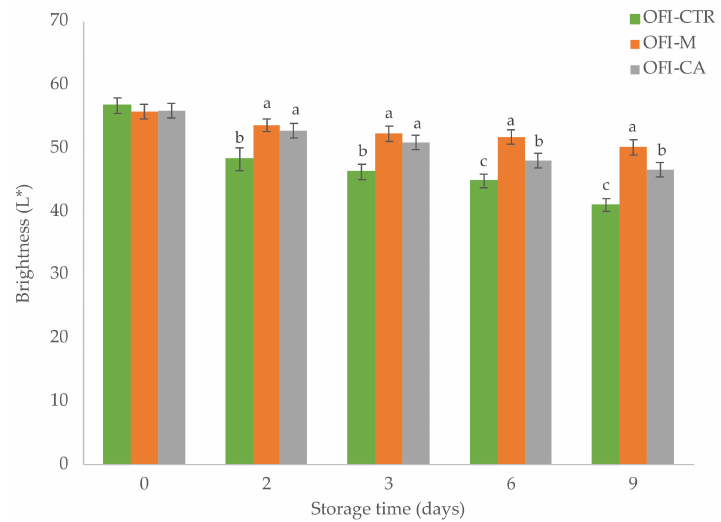
Figure 2. Changes in brightness (L*) in minimally processed O. ficus-indica fruits non-treated (OFI- CTR) and treated with mucilage (OFI-M) and calcium ascorbate coating (OFI-CA) during cold storage (9 days at 5 ◦ C). Different lowercase letters indicate significant differences between the treatments in each sampling date. Data are the mean ± SE ( n =